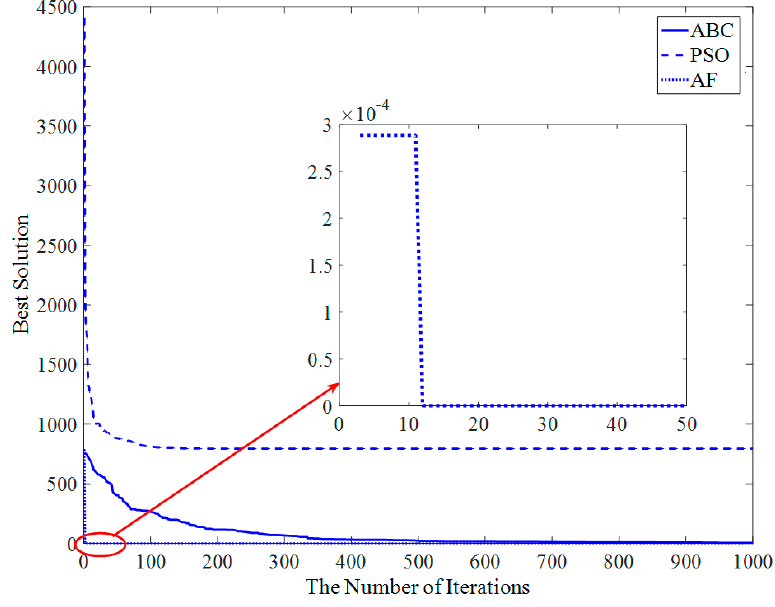
Figure 11. The convergence curve of the three algorithms for Rastrigin function in 50-dimensional space.